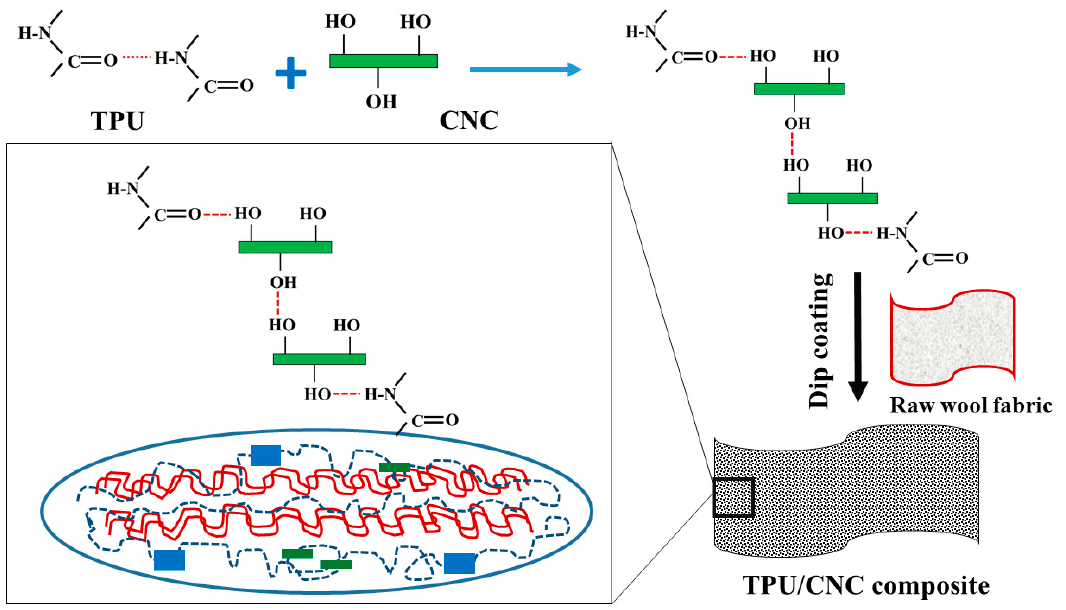
Figure 17. Fabrication procedure of dual responsive smart wool fabrics functionalized by nanocom- posite polymer (TPU polymer and CNC particles). Adapted from [197].